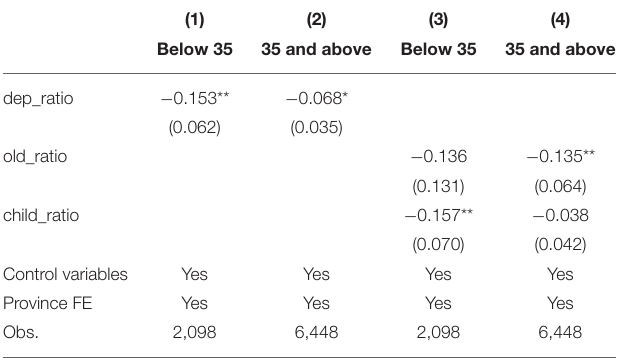
TABLE 4 | Regression results for age heterogeneous